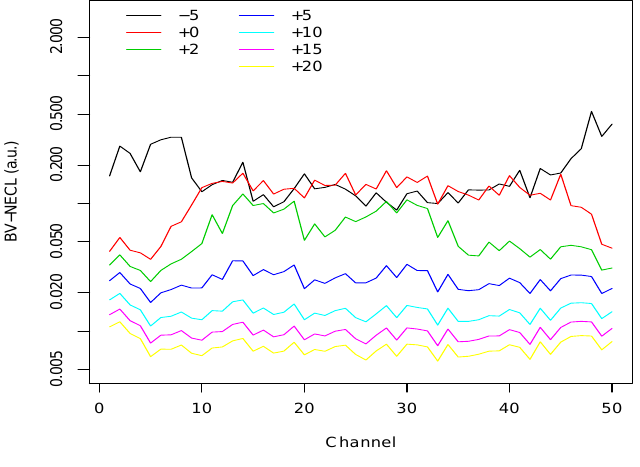
Figure 5. Segmented Basis Vector NECL Values: Group 11. NECL values for the 50 unit vectors (corresponding to the 50 spectral channels) were computed at 7 different plume temperatures from − 5 ◦ K to +20 ◦ K more than the average ground temperature 311 . 9 ◦ K. Only the pixels assigned to Group 11 were used in the